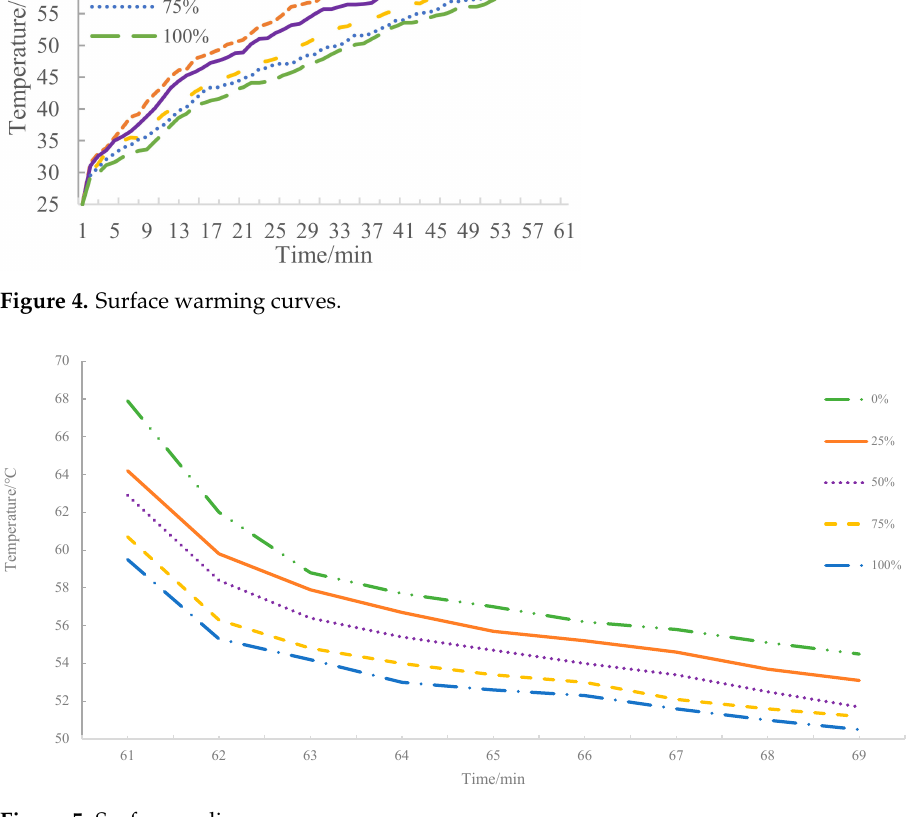
Figure 5. Surface cooling curves.